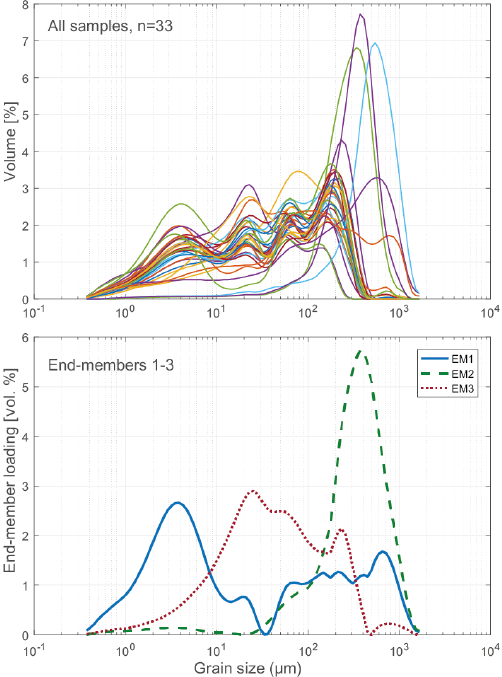
Figure 4. End-member analysis grain-size distributions in 33 sam- ples from Lake Bolshoe